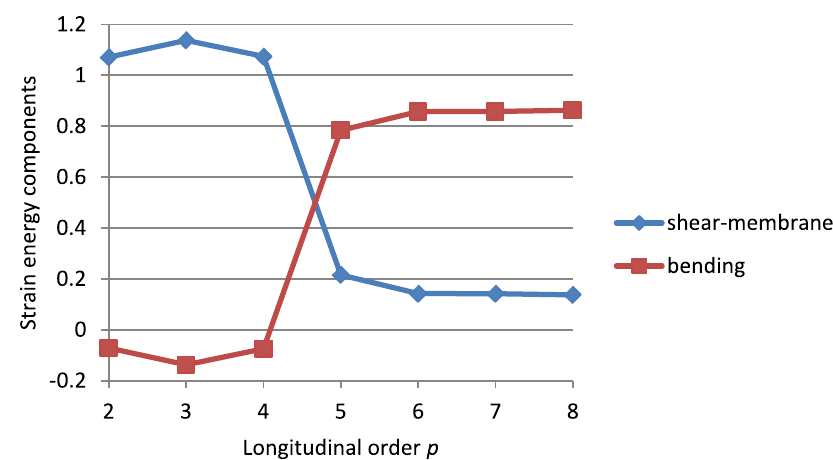
Figure 5. The sum of local energies—the bending-dominated shell.